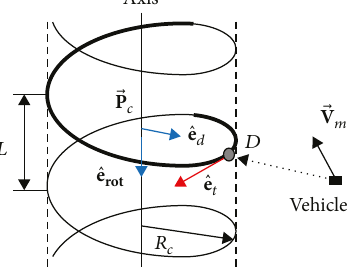
Figure 7: Helical path